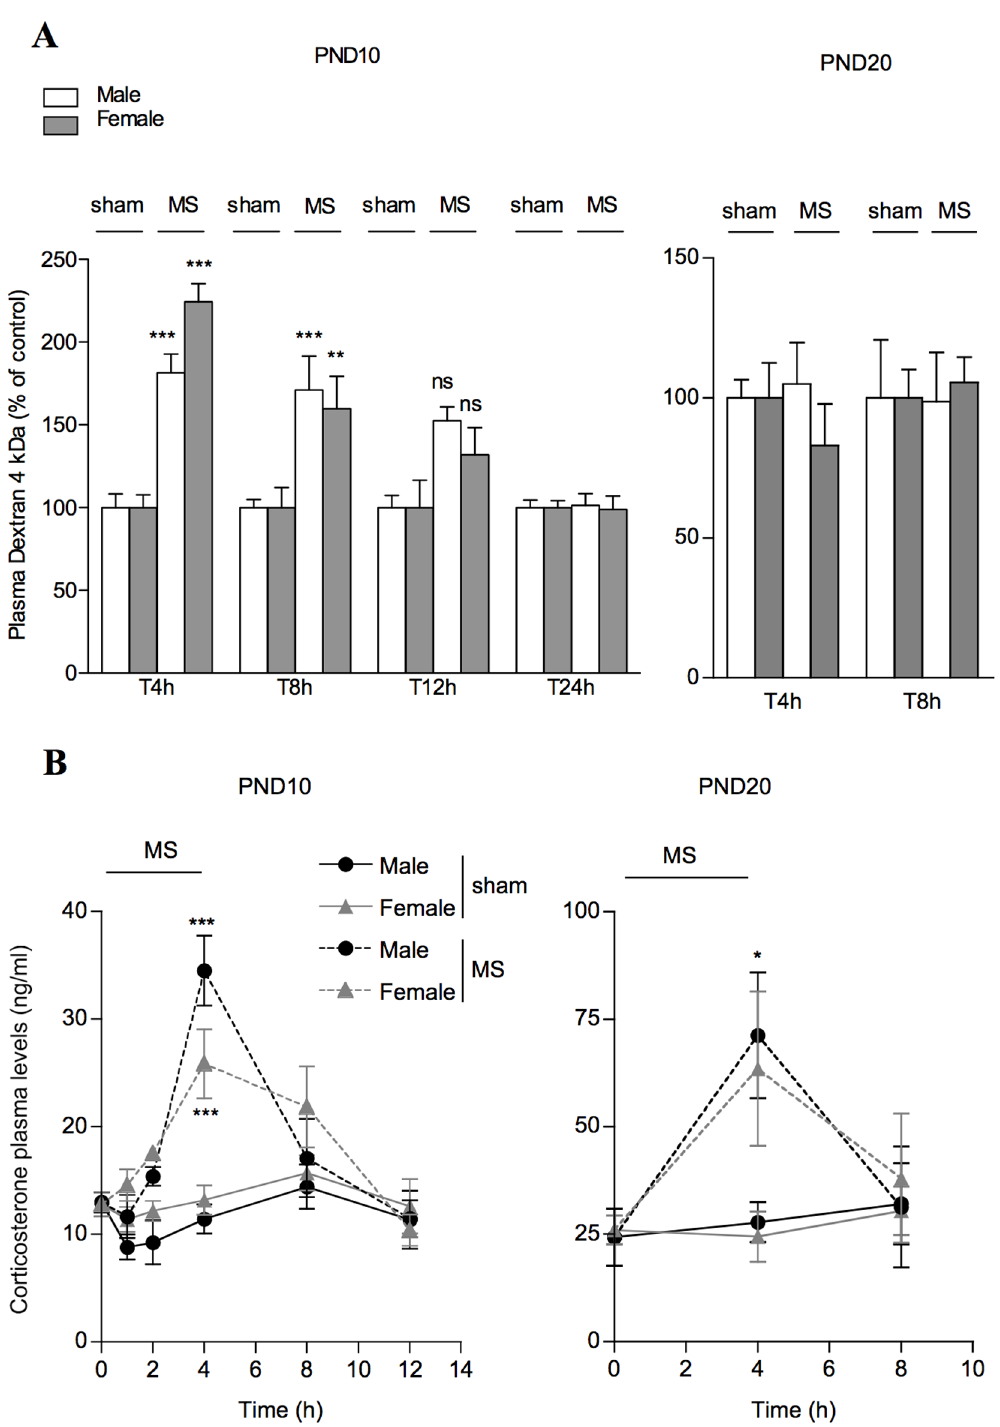
Figure 2. Effect of a single MS for 4 h on IP and plasma CORT in PND10 and PND20 rats. (A) Data show in vivo IP to FD4 immediately after MS (T4 h), and after the pups were returned to their dams (T8 h, T12 h and T24 h). Note that only PND10 rats displayed increased IP in response